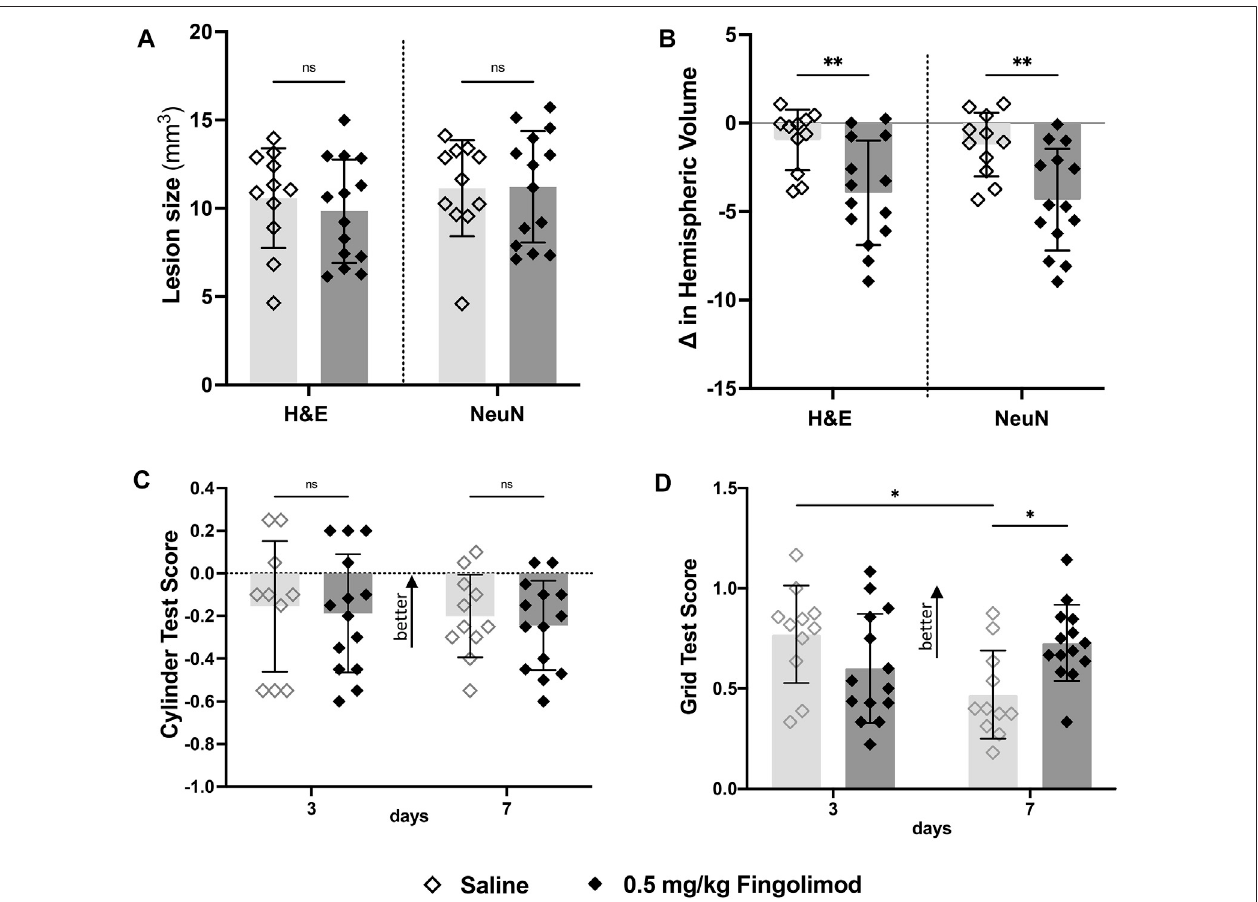
FIGURE3| Agedmouse study — (A) Lesion sizemeasurements,bystainingmethod;there wasnodifference inlesion size7 days after stroke betweentreatments for both staining methods. (B) Difference in volume between brain hemispheres; fi ngolimod (0.5 mg/kg) treated mice had a signi fi cantly reduced ipsilateral hemispheric volume compared to saline. (C) Cylinder test results at 3- and 7-days post stroke by treatment group (negative scores represent preference for the left paw usage (ipsilateral)); there was no difference in scores over time. (D) Grid walking test scores (scores closer to 1 represent a more comparable number of missed steps on each side);saline-treatedmicescoredsigni fi cantlyworsethantheirday3scores,micetreatedwith fi ngolimoddidnotdifferintheirscores. ◇ Saline( n =11) ◆ 0.5 mg/kg fi ngolimod ( n = 14). Mean ± SD; ns - not signi fi cant; * p < 0.05; ** p < 0.005; *** p < 0.0005.